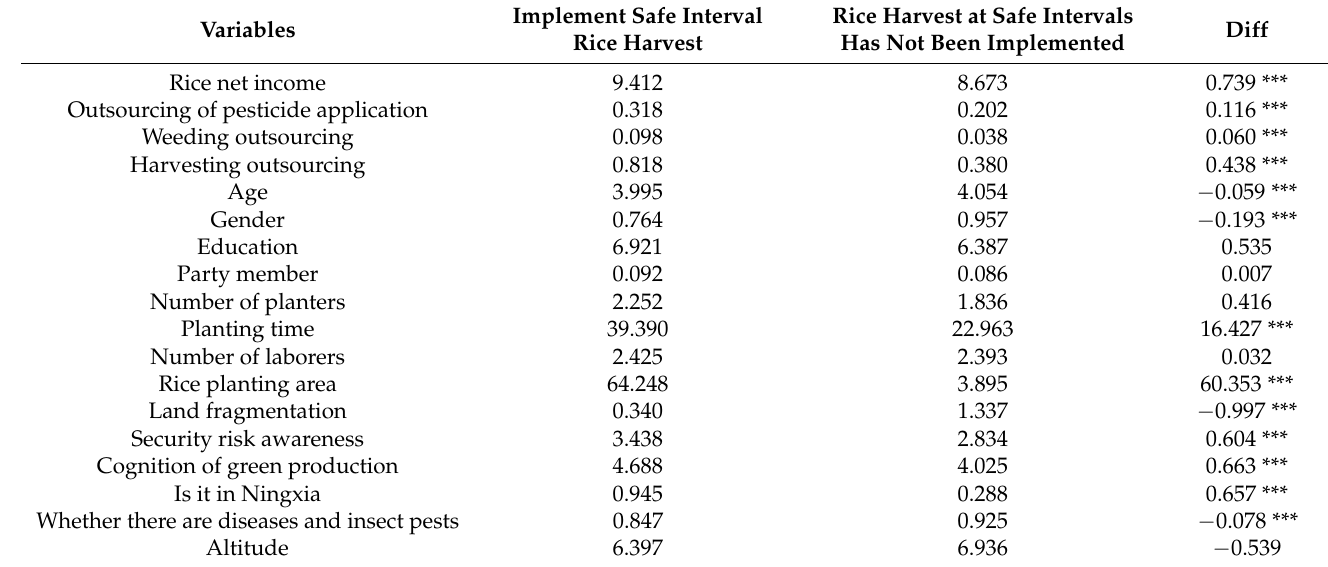
Table 3. The descriptive statistics and differences of rice farmers with and without safe interval rice harvesting